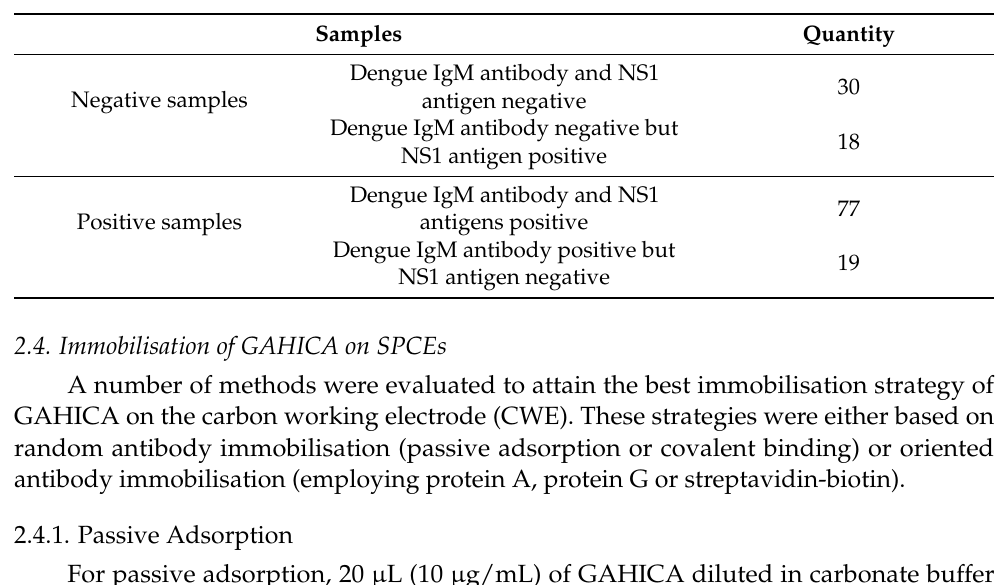
Table 1. Details of reference serum samples used during diagnostic